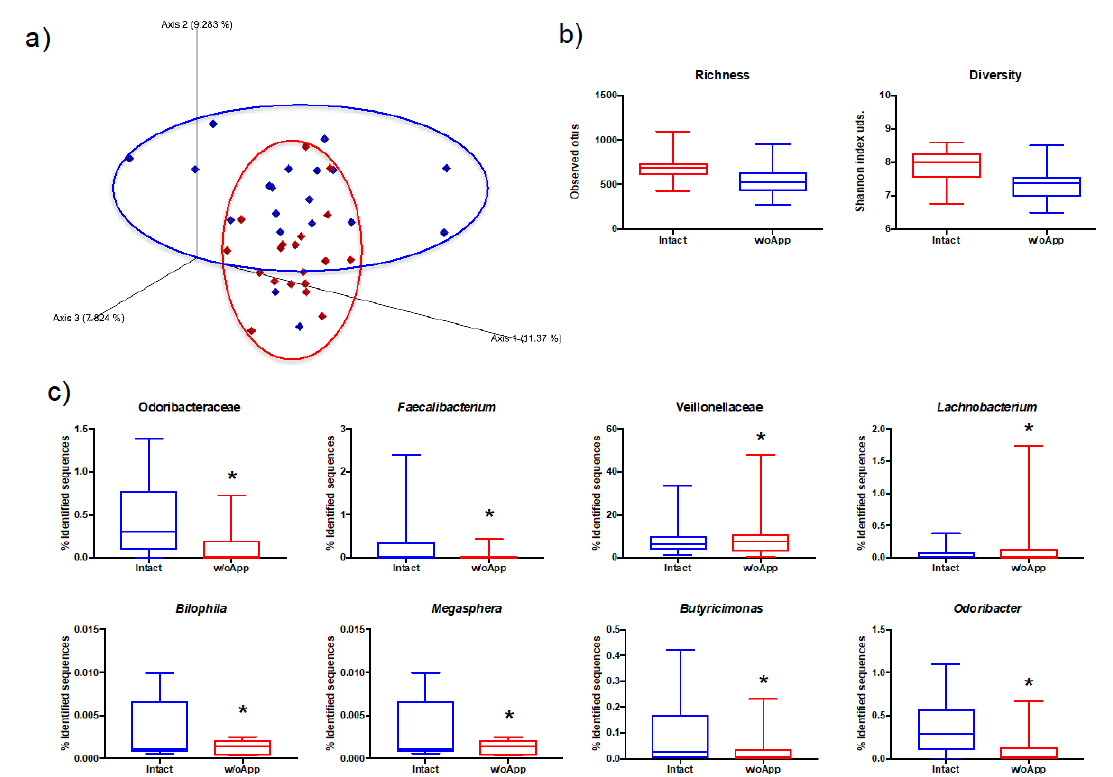
Figure 1. ( a ) Principal Coordinates Analysis (PCoA) of bacterial communities from patients who underwent incidental prophylactic appendectomy and in stool samples from these patients (w / oApp, blue) and from patients with their appendixes intact (Intact, red) during bariatric surgery. ( b ) Estimate richness and diversity indices between stool bacterial communities from Intact and w / oApp patients. ( c ) Di ff erential abundant bacteria between the stool samples from Intact and w / oApp patients analyzed with the method of RNAseq with EdgeR analysis (* indicates FDR-corrected p -value < 0.05). Di ff erential abundance analysis (Figure 1c) revealed particular di ff erences between groups in fecal samples at the family level: Odoribacteriaceae ( q -value = 0.011) and Veillonellaceae ( q -value = 0.048), − 9 while at the genus level: Megasphaera ( q -value = 8.20 × 10 ), Odoribacter ( q -value =